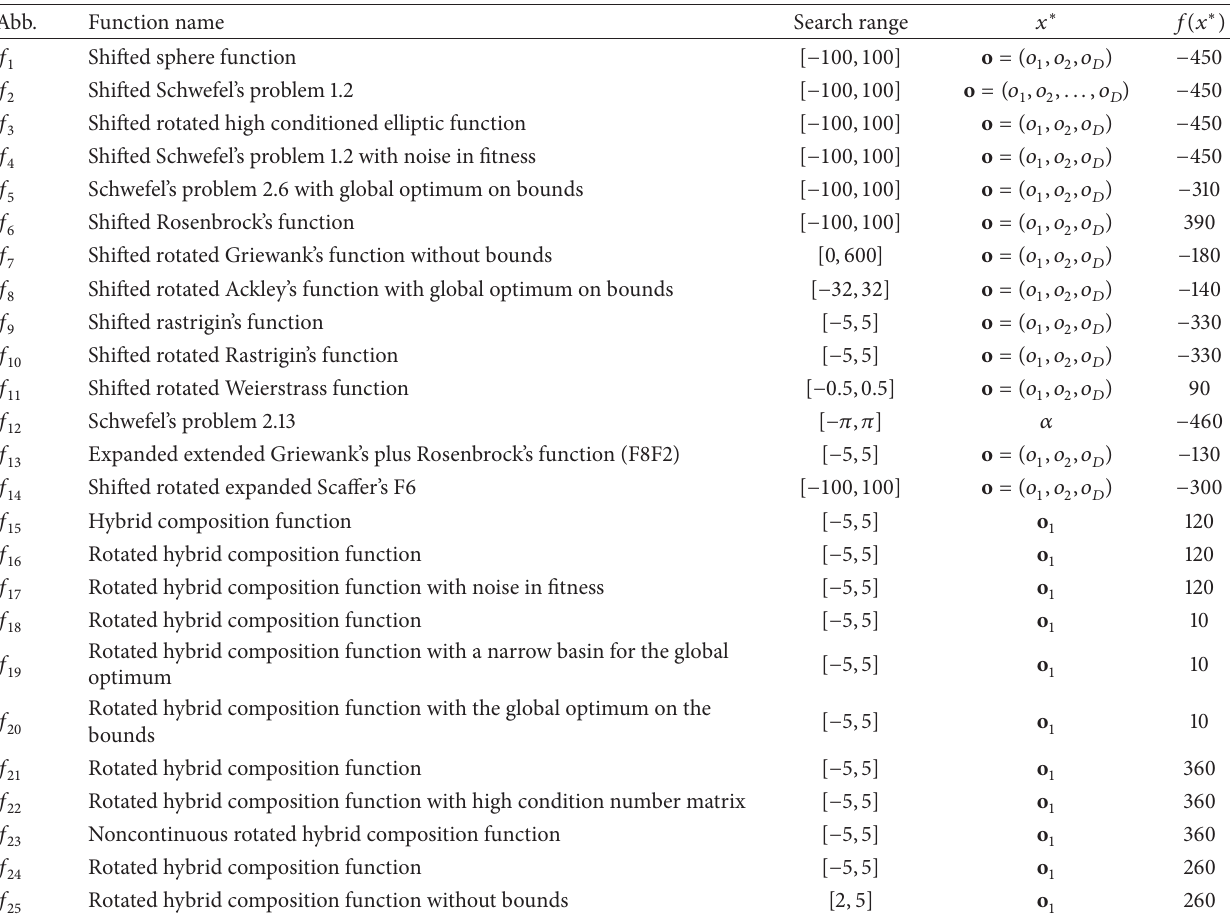
Table 1: CEC’2005